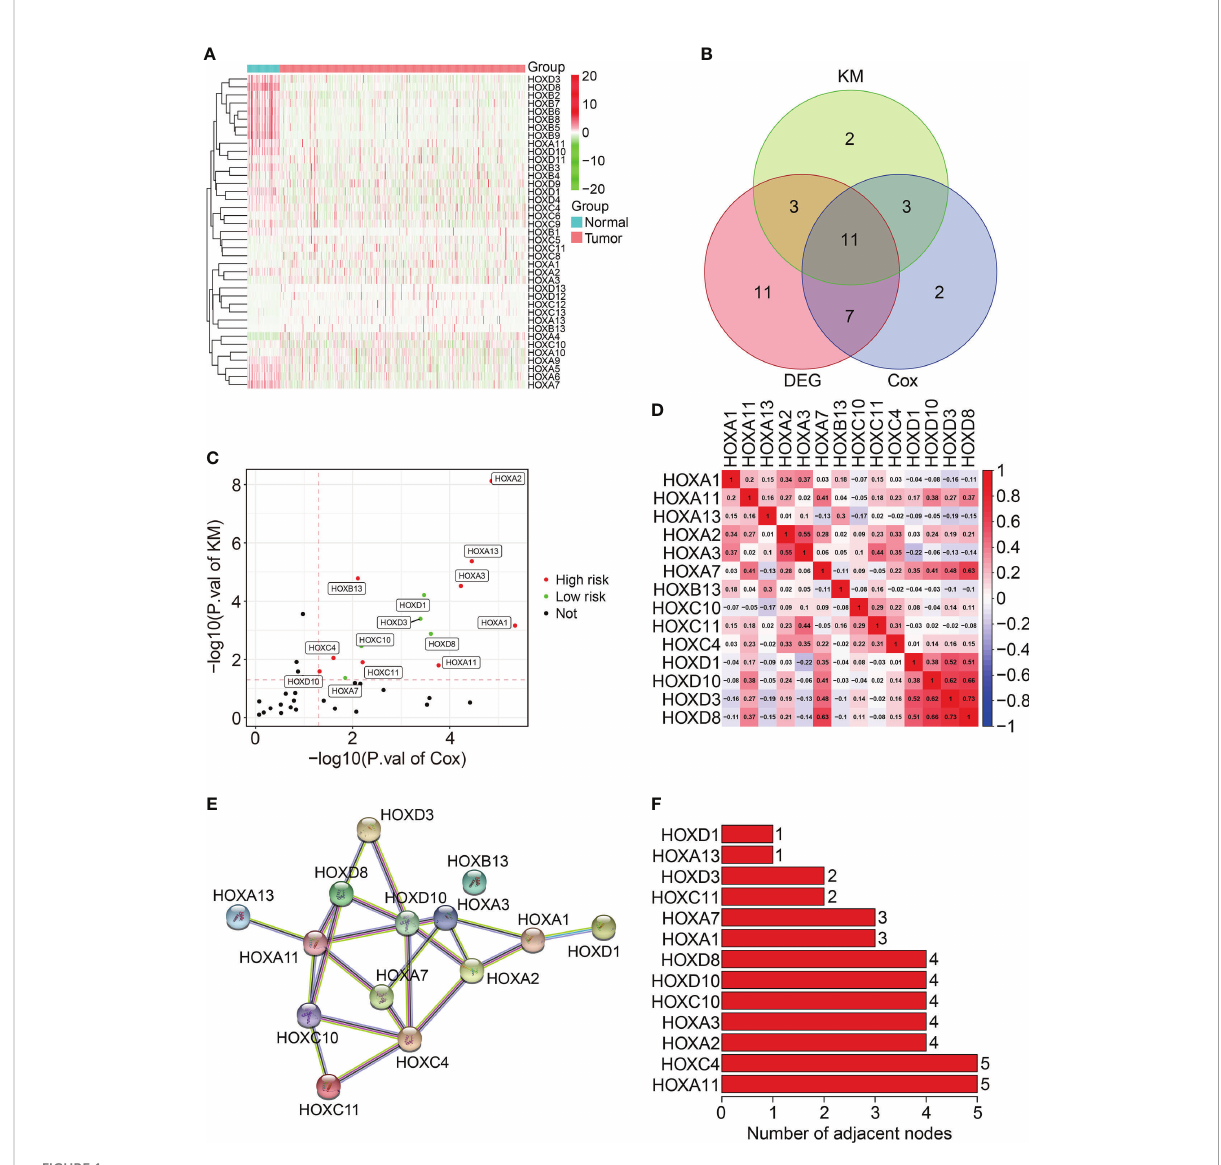
FIGURE 1 Characterization of homeobox family genes in ccRCC based on TCGA database. (A) Heatmap showing the expression patterns of HOX family genes in tumor tissues and adjacent normal tissues. (B) Venn plot showing the number of differentially expressed HOX genes and prognosis- related HOXs. (C) Volcano plot showing the prognosis-related HOXs based on univariate Cox regression analysis and Kaplan-Meier survival analysis. (D) Correlation heatmap of the 14 prognosis-related HOXs. (E) Protein-protein interaction network of the 14 prognosis-related HOXs. (F) Hub genes in the PPI